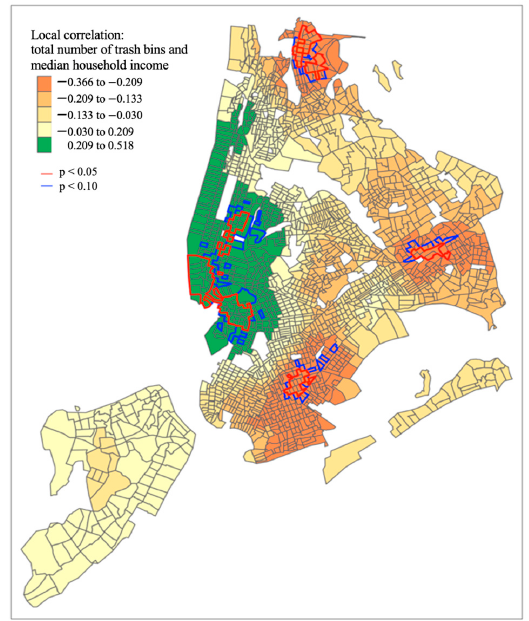
Figure 3. Mapping correlation between count of litter bins and median household income.